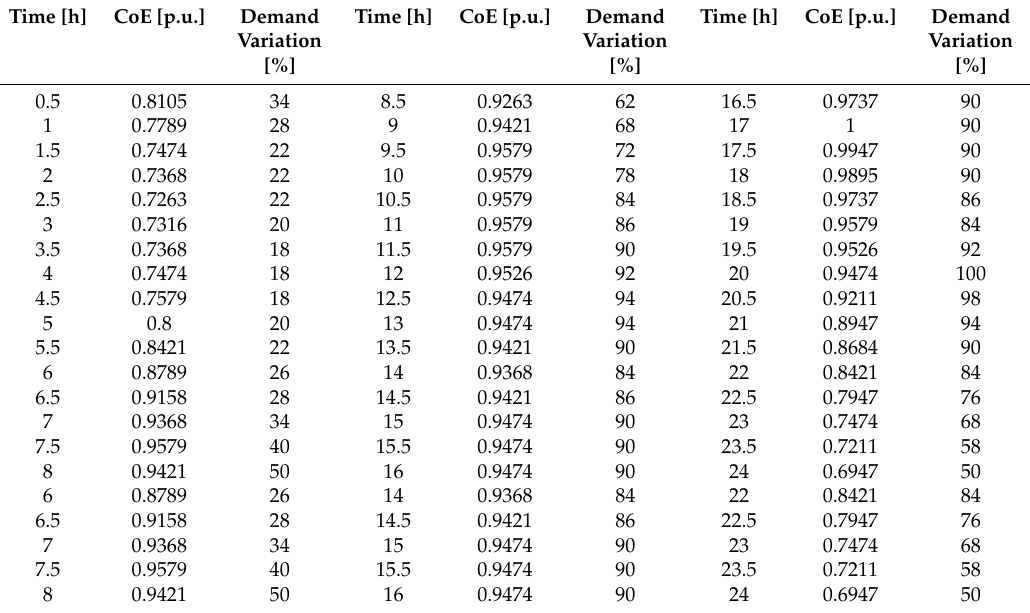
Table 3. Energy purchasing cost and hourly demand.